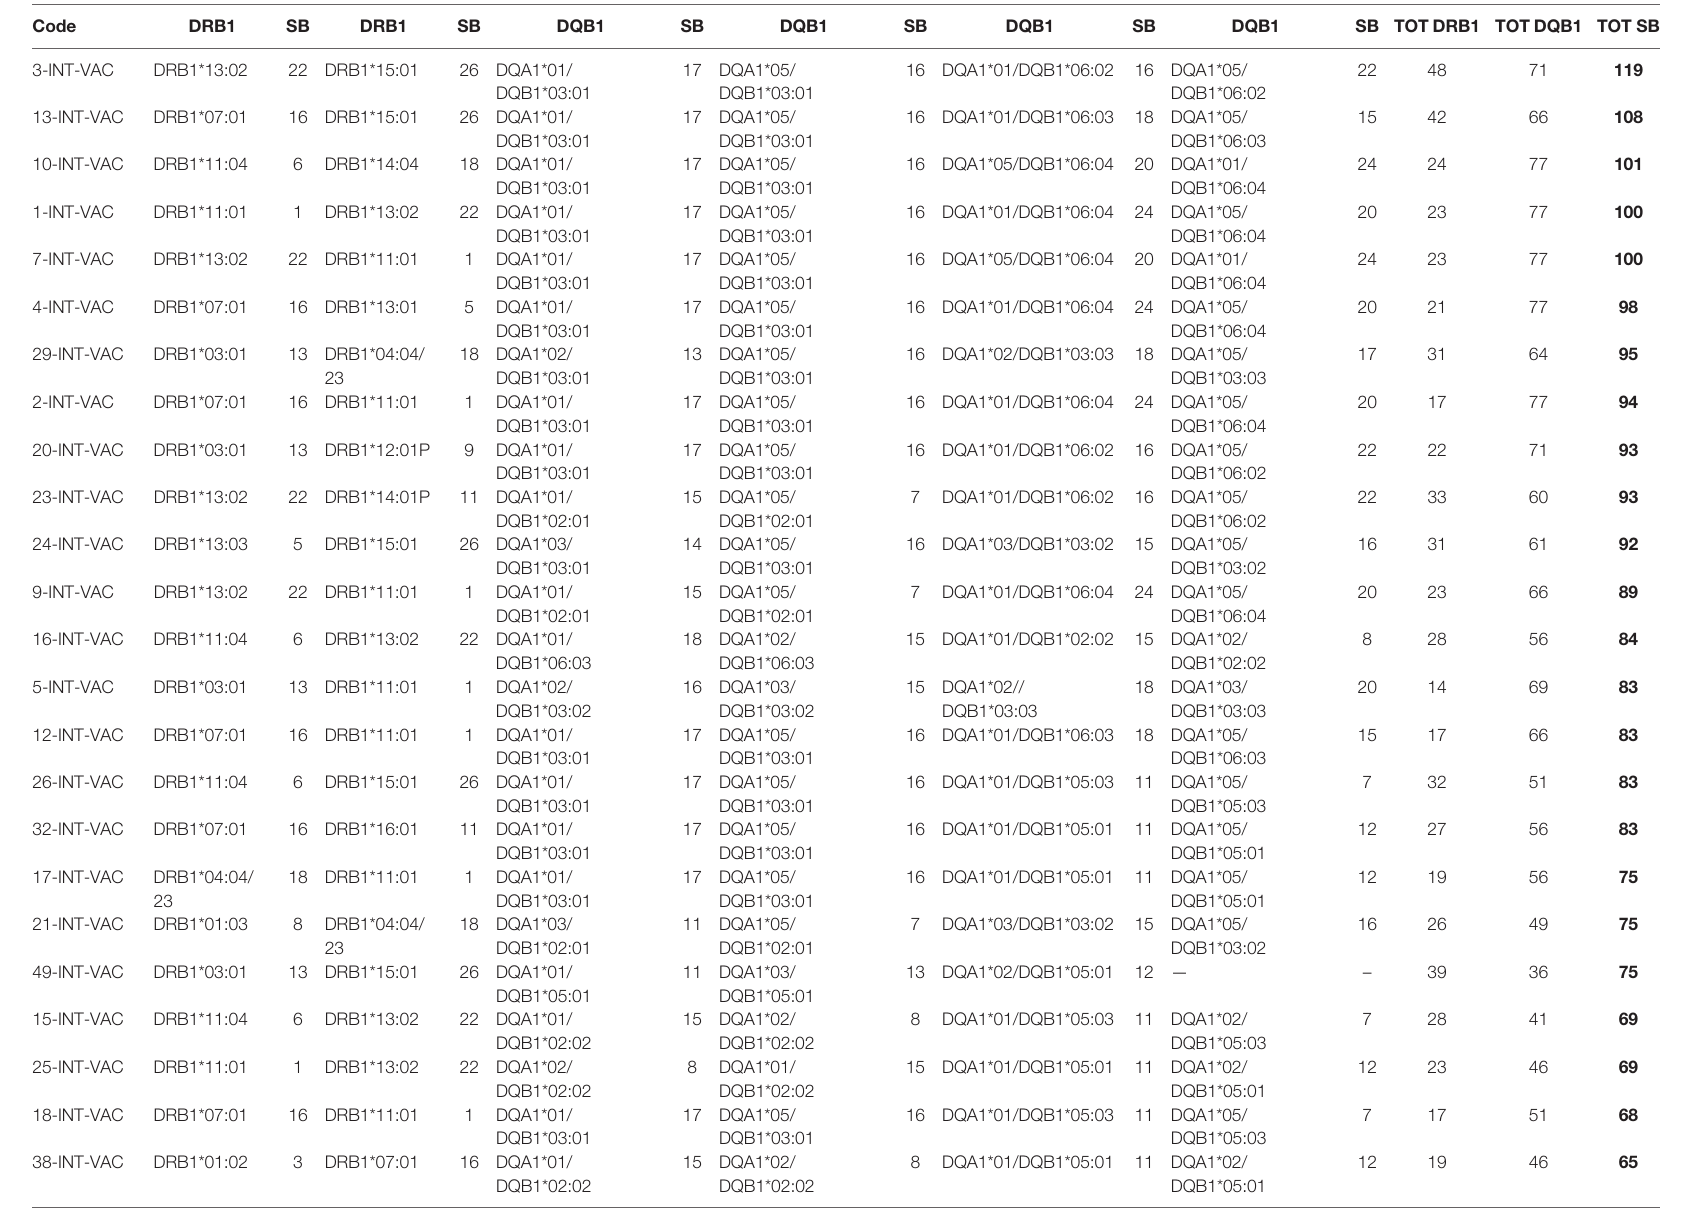
TABLE 3 | HLA DR and DQ alleles identi fi ed in the enrolled